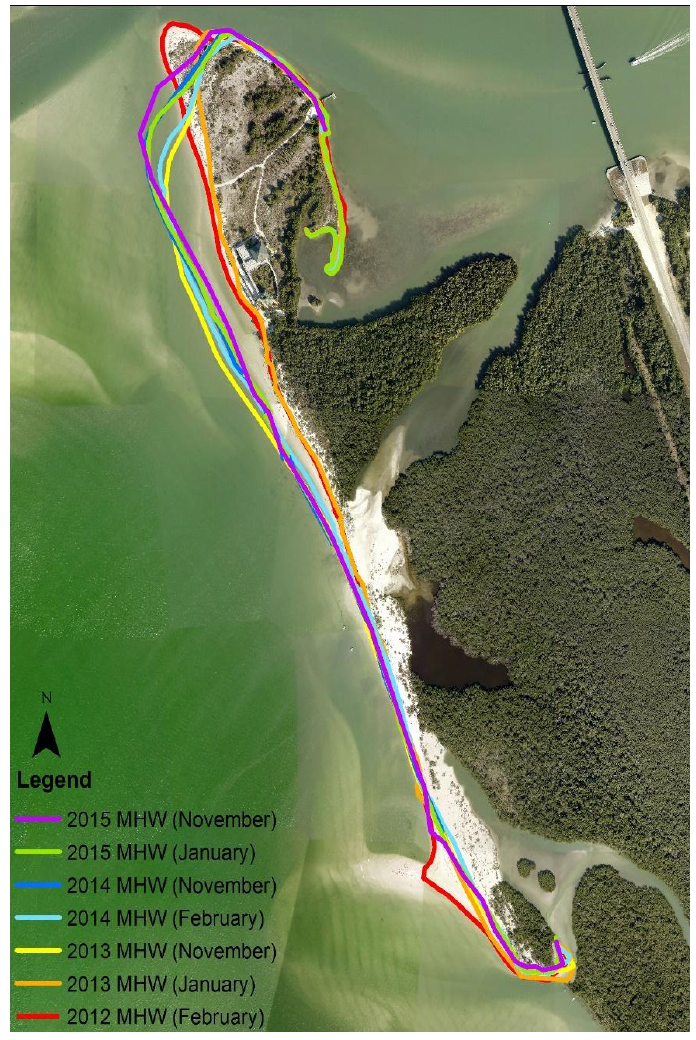
Figure 6. Morphologic changes of Big Hickory Island between 2012 and 2015, represented by the Mean High Water (MHW) line surveyed bi ‐ annually, shown on a 2012 aerial photograph.